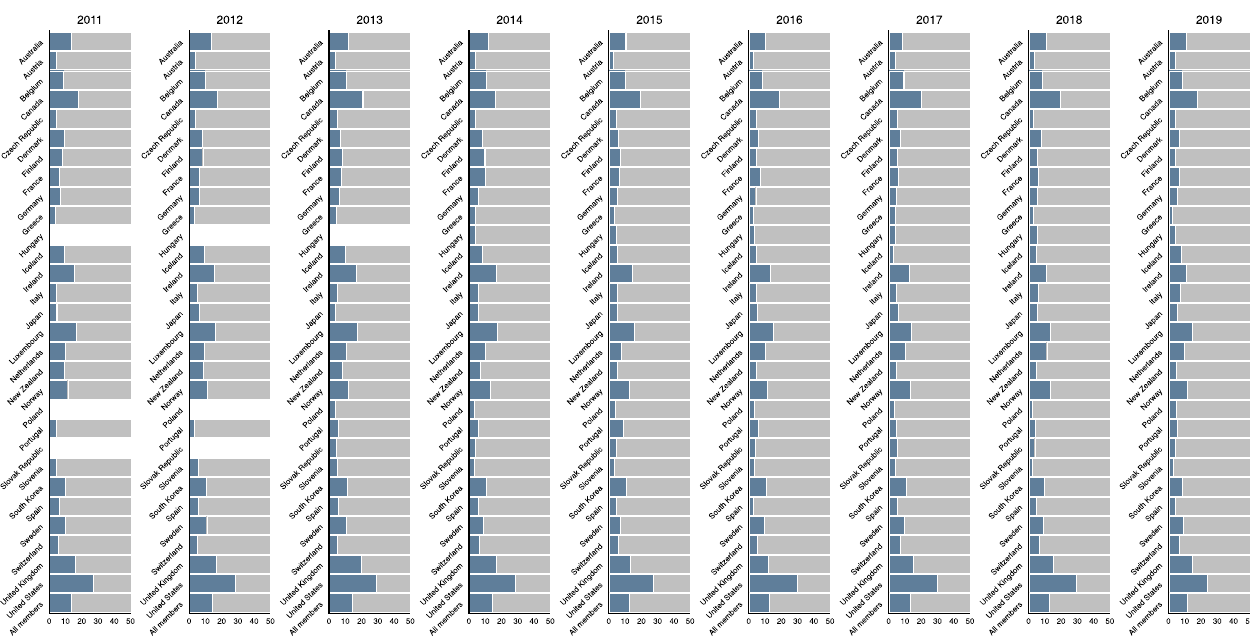
Int. J. Environ. Res. Public Health 2021 , 18 , x FOR PEER REVIEW Figure 1. Proportion of estimated DAH in ODA for all the 29 DAC member countries, 2011–2019. Blue: DAH; Gray: ODA for non-health areas; DAH: development assistance for health; DAC: Development Assistance Committee.